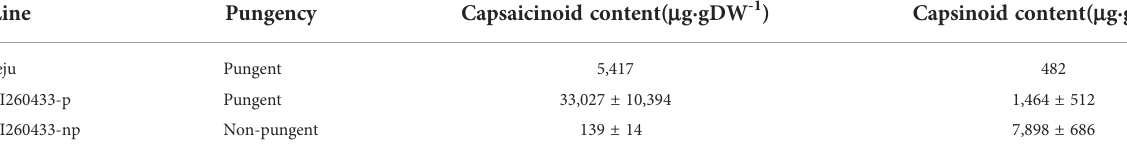
TABLE 1 Levels of capsaicinoids and capsinoids in the placental tissue in parental lines.